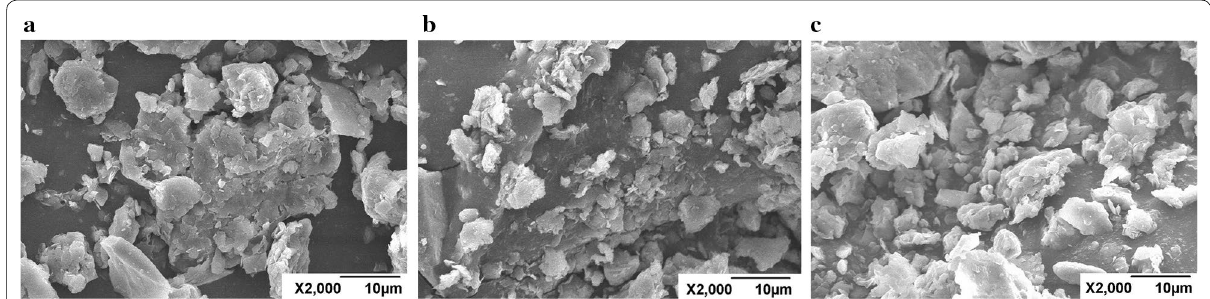
Fig. 6 SEM pictures of bentonite treated with different methods. a Virgin bentonite, b bentonite treated with water, c bentonite treated with DEM-